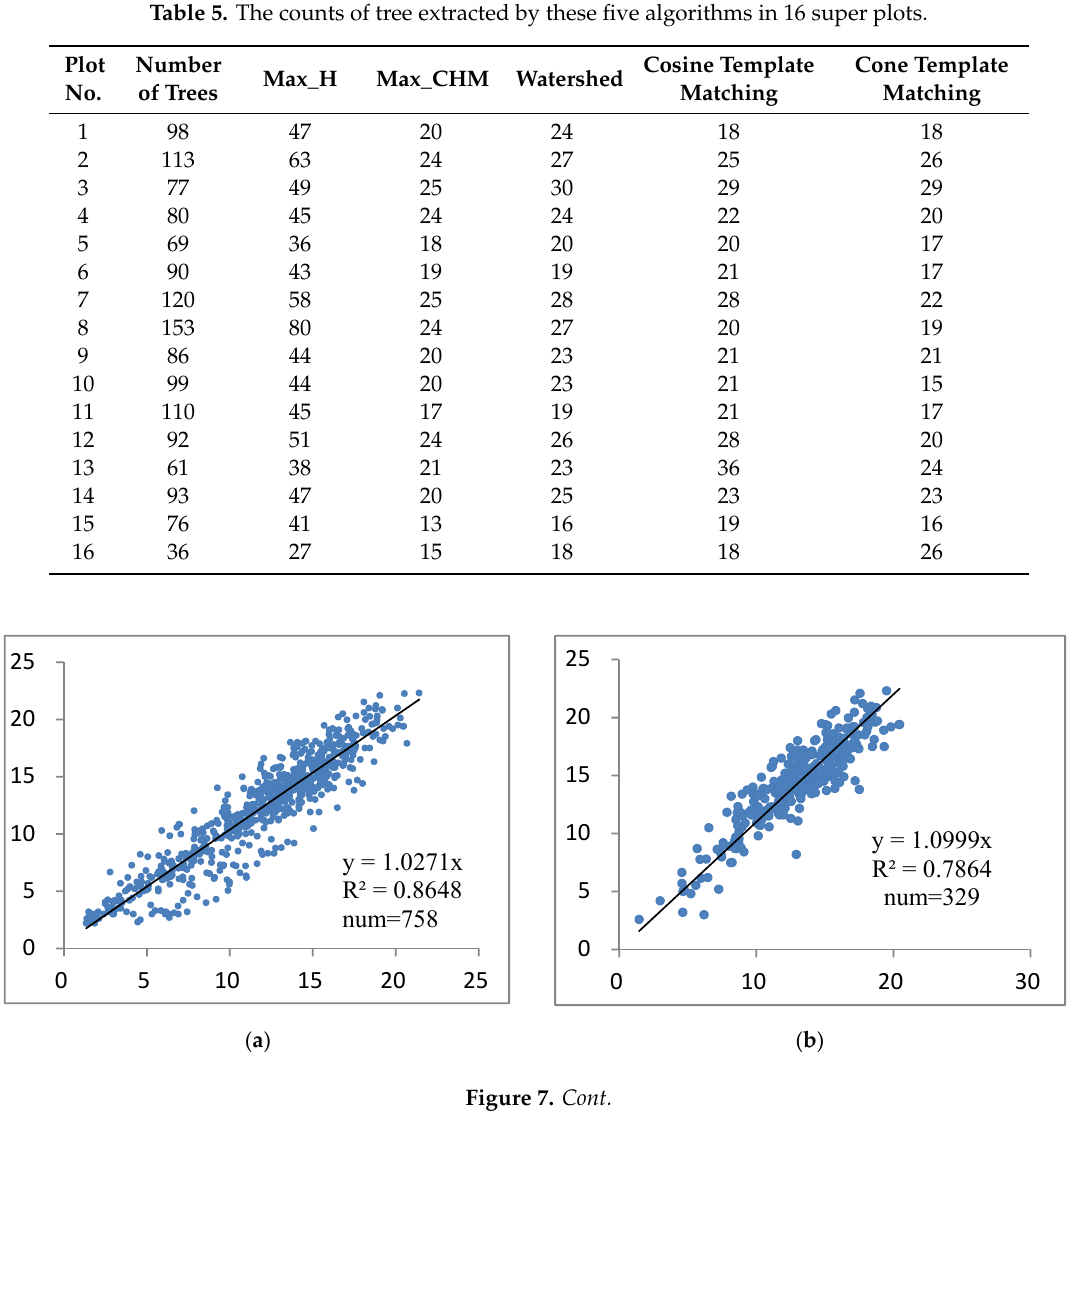
Figure 6. The distribution of the individual trees extracted by five different algorithms: ( a ) Max_H, ( b ) Max_CHM, ( c ) watershed, ( d ) cosine-template-matching, and ( e ) cone-template-matching algorithms.